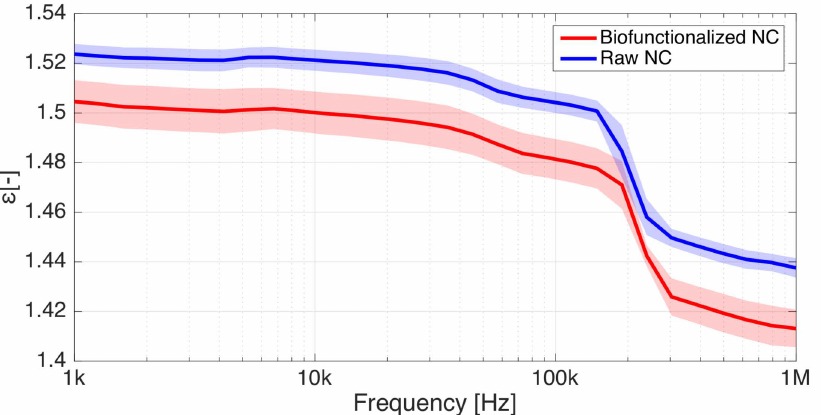
Figure 4. Relative permittivity of raw and CBD-biofunctionalized nitrocellulose membranes over 1 kHz–1 MHz. The biofunctionalization process causes a small decrease in the permittivity. Total number of samples: 7. Shaded area surrounding the measurement curves: standard error ( σ ).